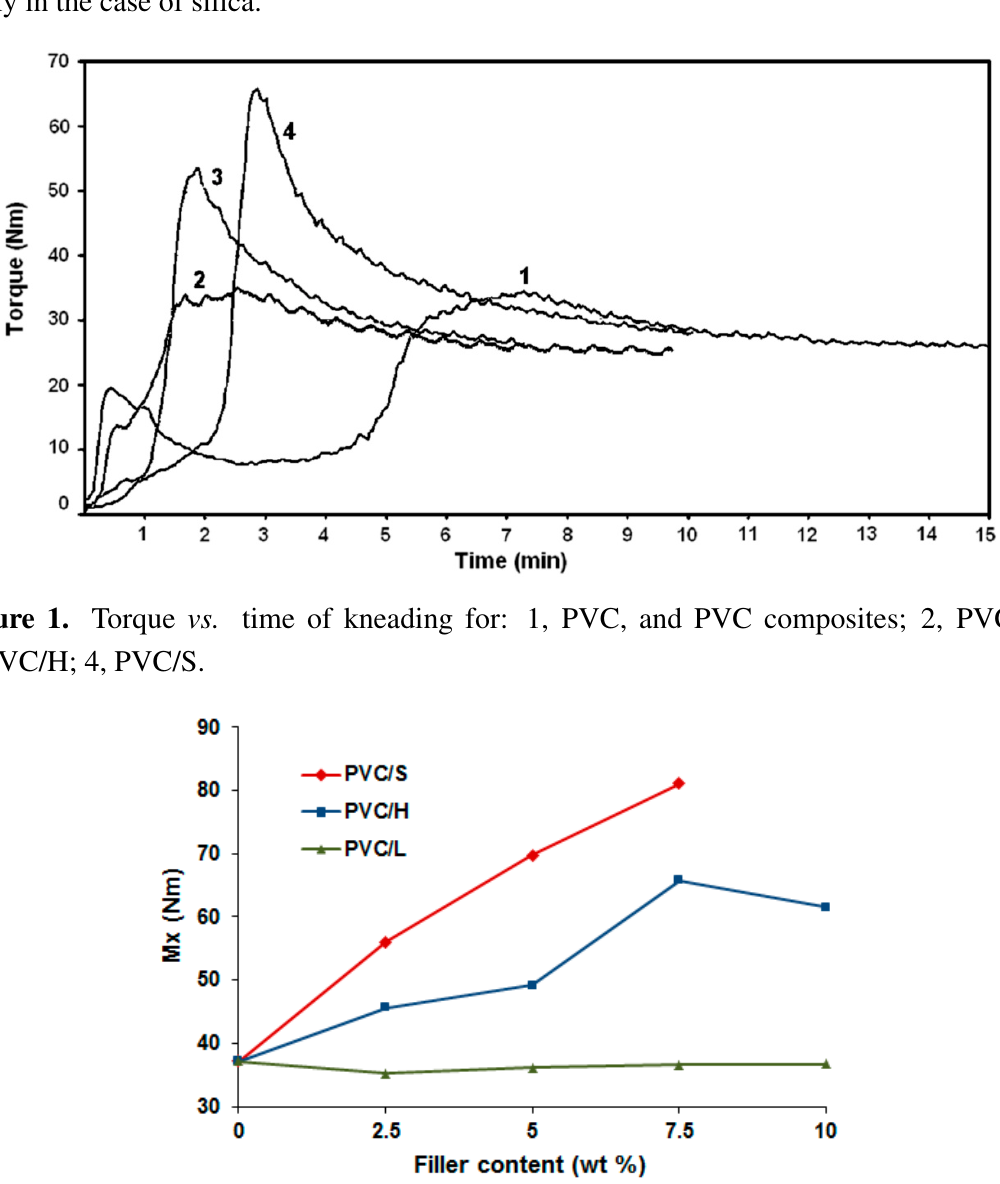
Figure 2. Maximum value of torque ( M X ) for PVC and PVC composites as a function of filler content.